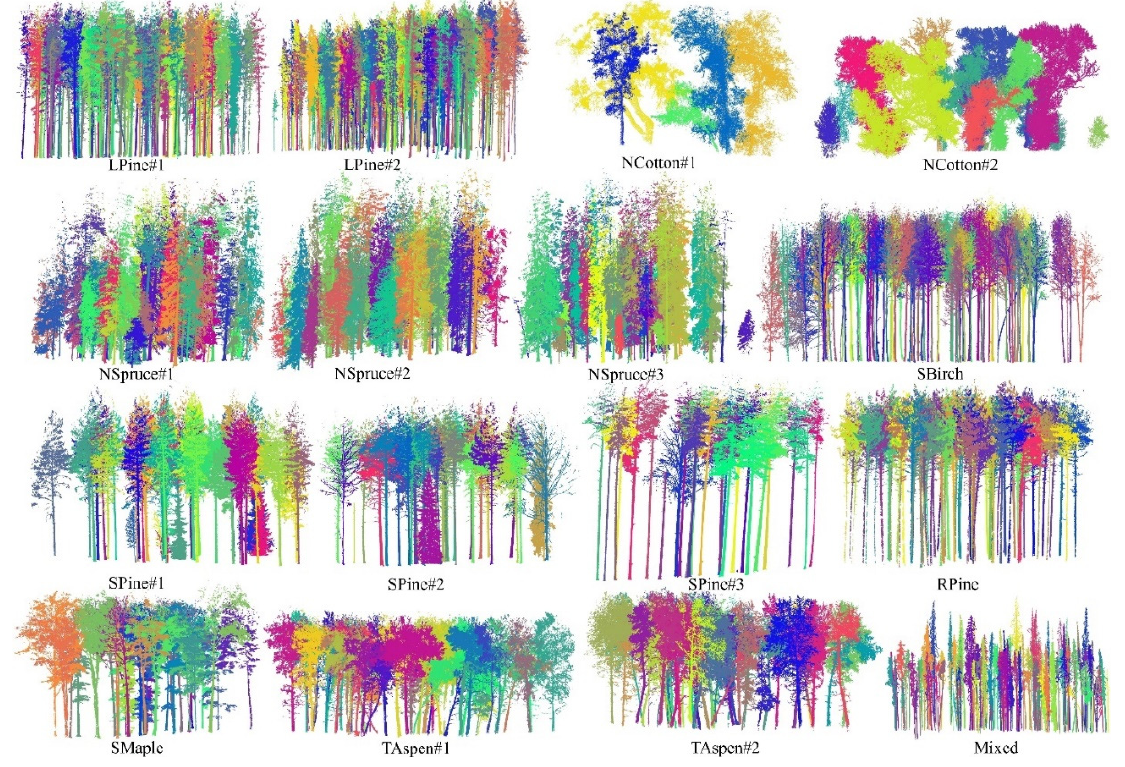
Figure 2. Manually isolated point clouds from sixteen TLS plot scans. Each individual tree was assigned a random color to help visual identification. Geolocations of eight Canadian sites with TLS scan collection. Ecozone names are Italic. Table 1. Characteristics of sixteen TLS